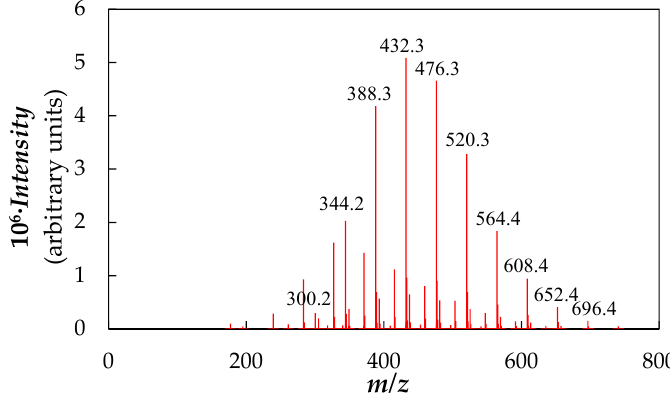
Figure 1. Positive ion electrospray ionization (ESI) mass spectra of neat PEG400.